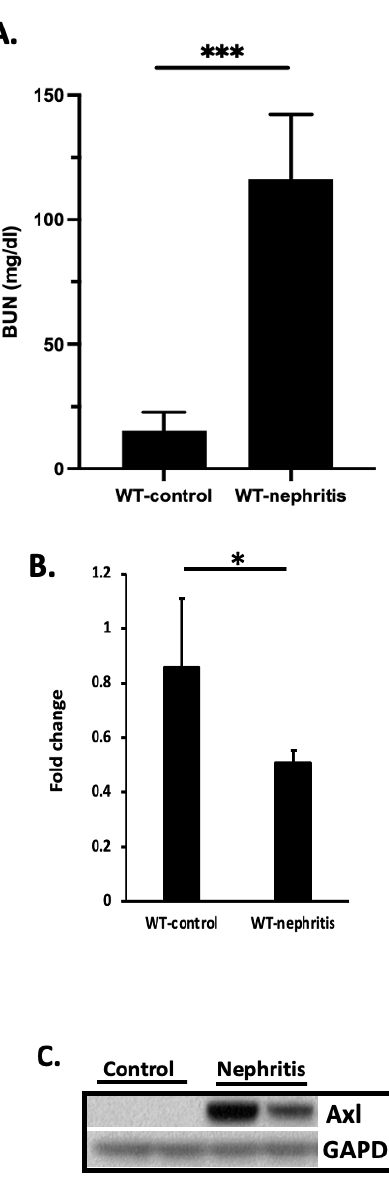
Figure 5. MiR34a levels inversely correlates with Axl expression. ( A ) Glomerulonephritis was induced. Kidney function was evaluated by measuring BUN levels. *** p < 0.001 by Student t -test. ( B ) Expression of miR34a in the kidney of experimental animals was analyzed by RT-PCR. * p < 0.05 by the Student t -test. Data are representative of two individual experiments. A total of seven mice were analyzed for miR34a expression. ( C ) Axl expression levels were analyzed by Western blot from the same kidney preparation.